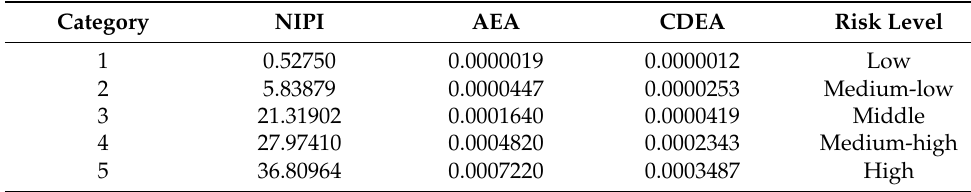
Table 1. Security risk assessment indexes of five cluster